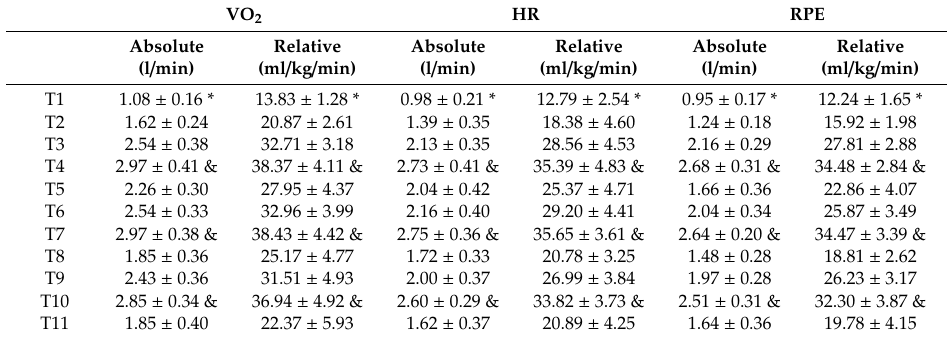
Table 3. Means and standard deviations of absolute (VO 2 Abs) and relative (VO 2 rel) oxygen uptake during three